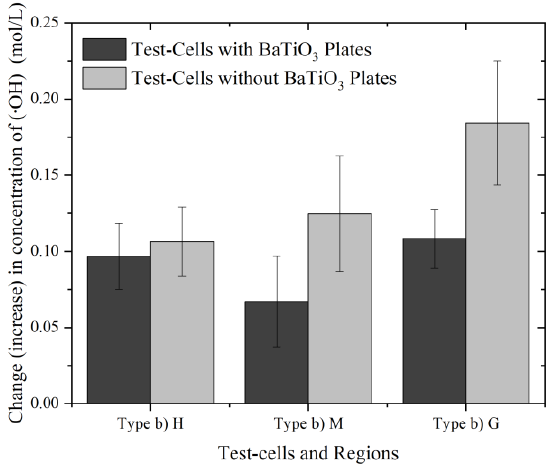
Figure 9. Effects of PEF treatment on the concentration of ( · OH) in yeast suspensions using different types of chambers. Error bars show standard deviation (n = 3). Table 4. Statistical analysis of the experimental results of hydroxyl radical concentration